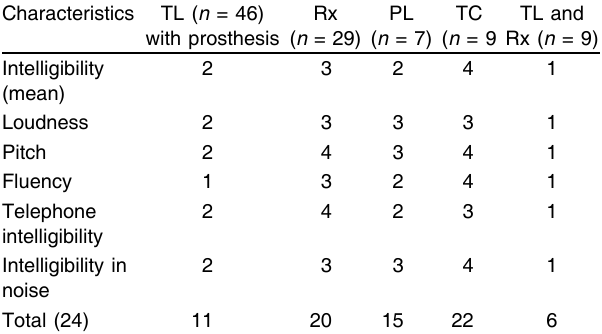
Table 5 Subjective evaluation of voice in patients of the study Characteristics